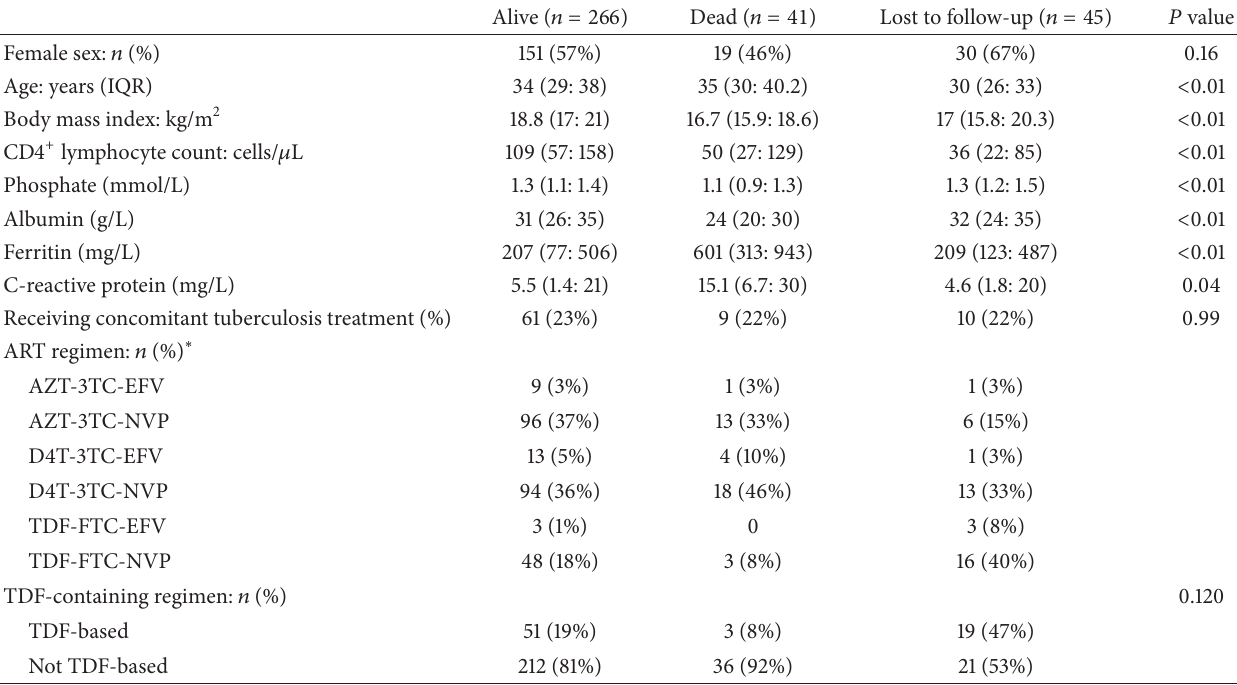
Table 1: Summary of baseline characteristics by 90-day outcome.